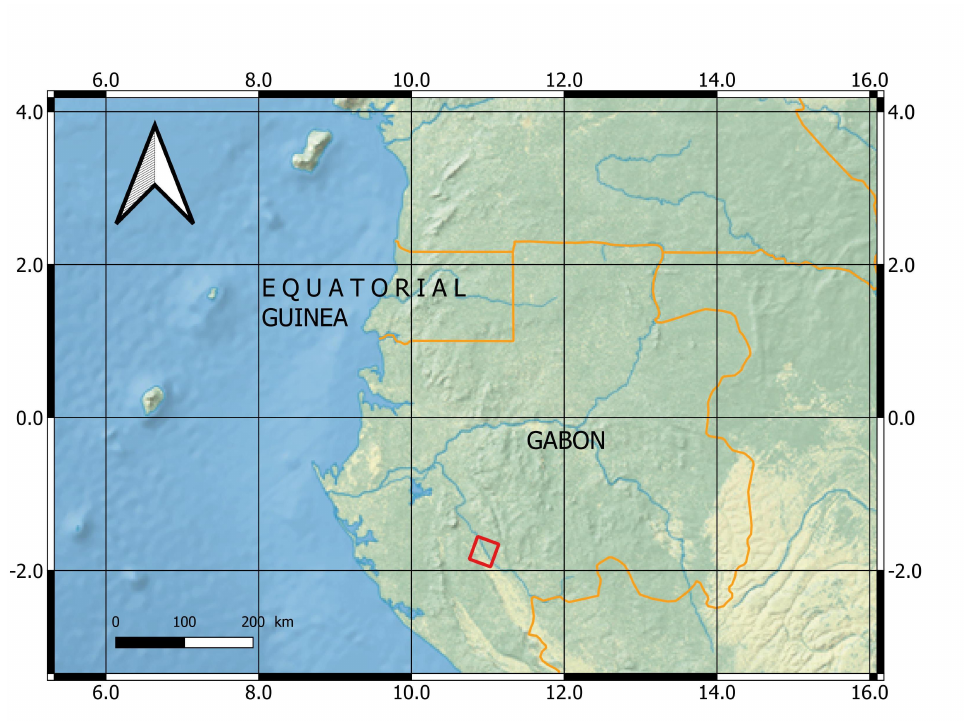
Figure 1. Geographical location of the test site in Gabon. A red rectangle indicates the particular area chosen for the present study. The map was made using Natural Earth. Free vector and raster map data can be found at naturalearthdata.com (accessed on March 2021).